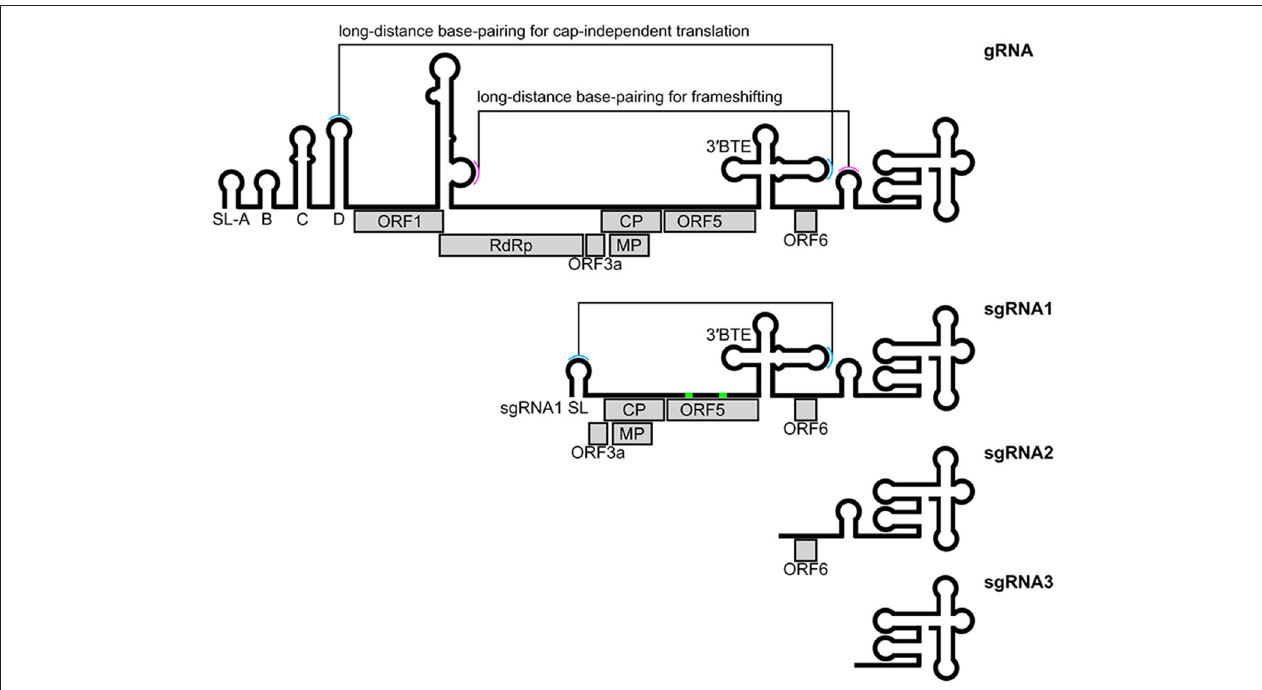
FIGURE 6 | Structured RNA elements of BYDV. CP readthrough elements are shown in green. BYDV, barley yellow dwarf virus; CP, coat protein; BTE, BYDV-like translation element; gRNA, genomic RNA; MP, movement protein; ORF, open reading frame; RdRp, RNA-dependent RNA polymerase; sgRNA, subgenomic RNA; SL,